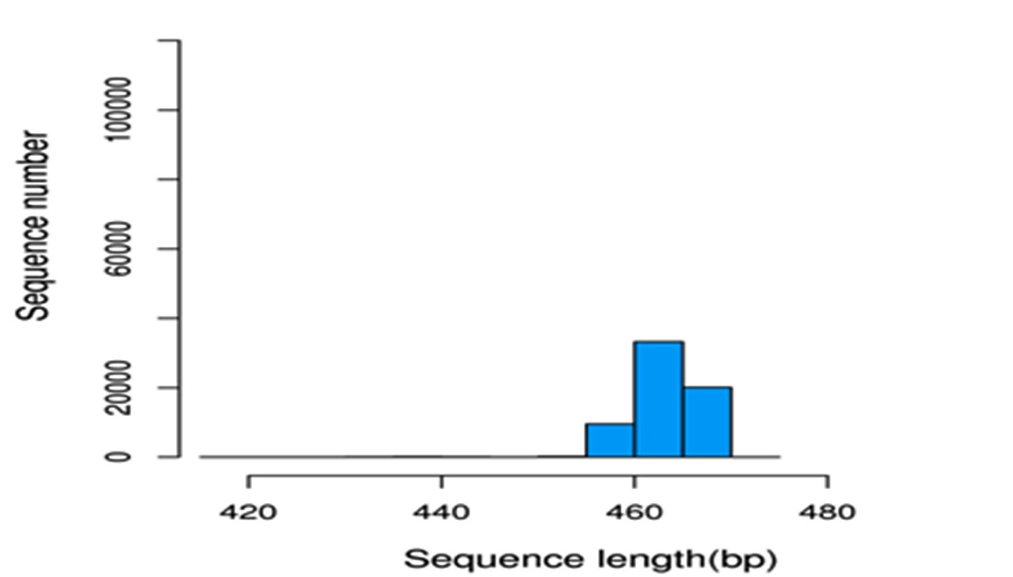
Graph I. Effective sequence length